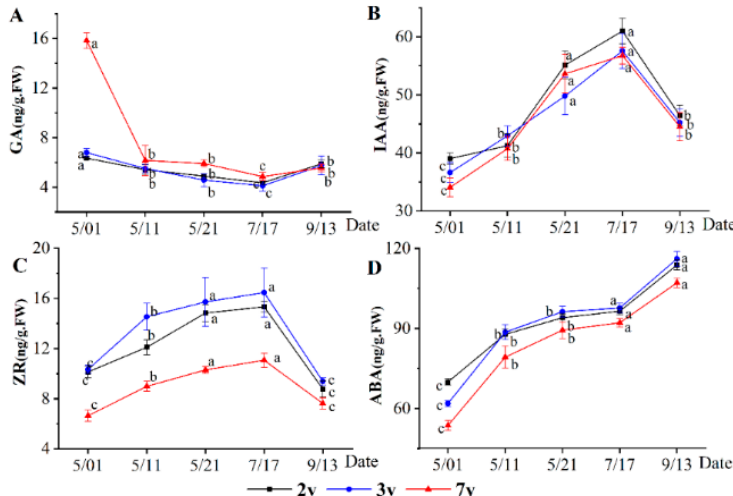
Figure 1. Changes in the endogenous hormones throughout the growth of G. uralensis Fisch. Different letters reflect significant differences among different indexes in the same stage: ( A ) GA content, ( B ) IAA content, ( C ) ZR content, and ( D ) ABA content.